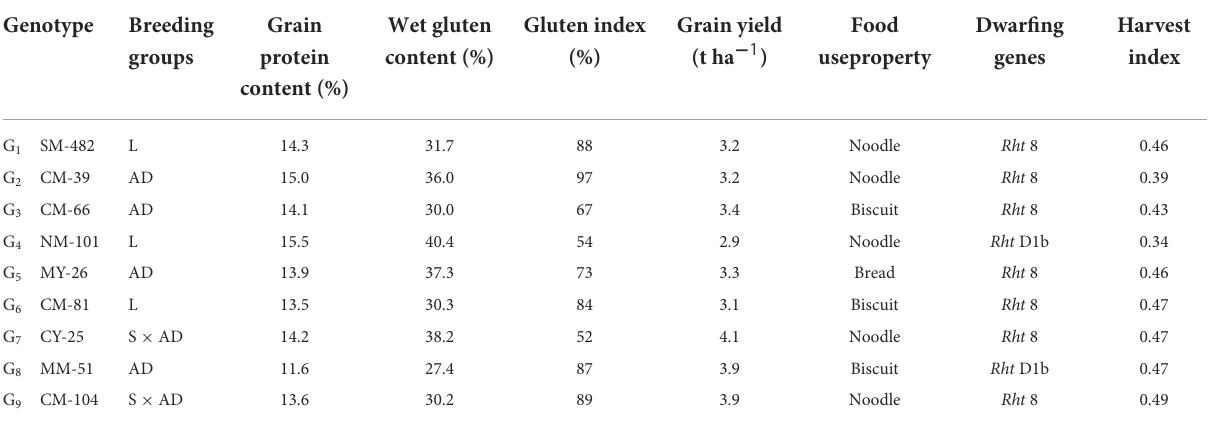
TABLE 1 Introduction about the basic information of nine wheat